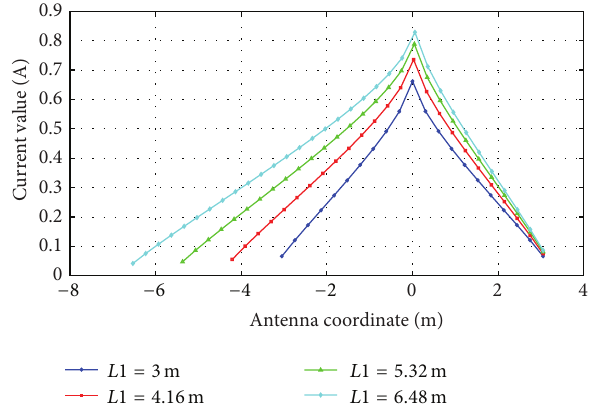
Figure 18: Current distribution on the asymmetric antenna